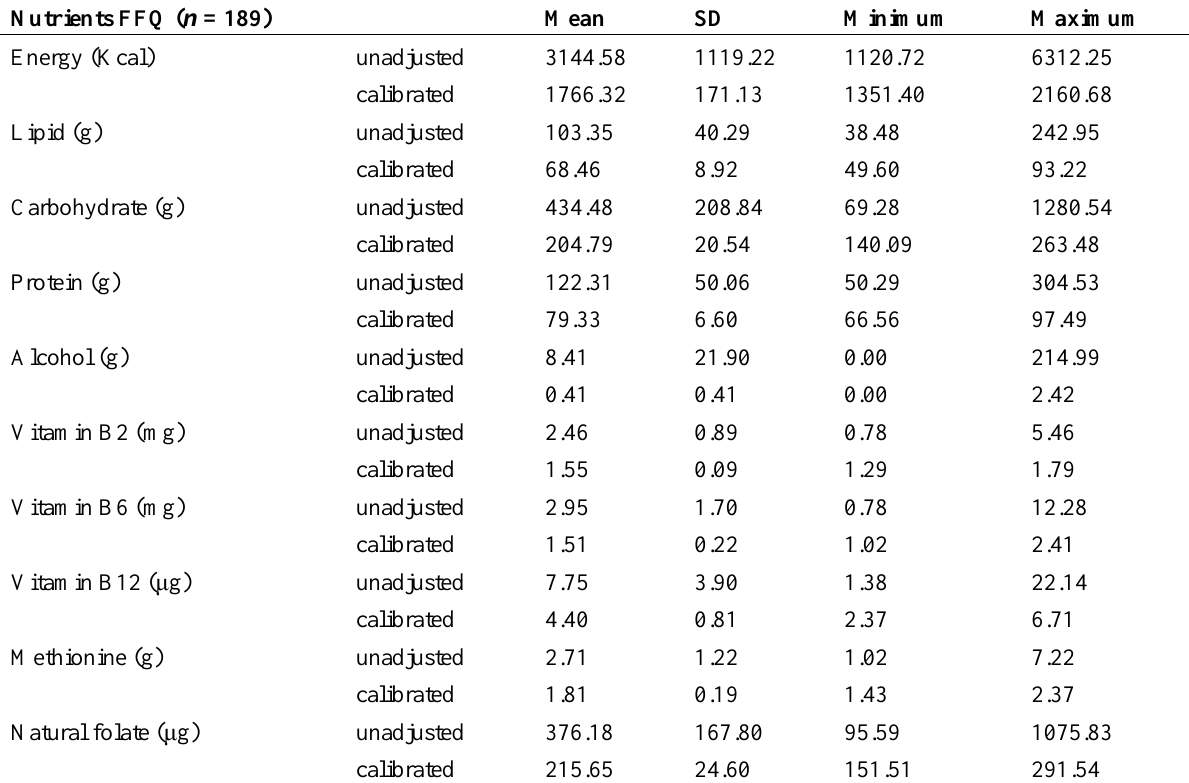
Table 1. Mean, standard deviation and minimum and maximum nutrient values from the unadjusted and calibrated FFQ in the pretreatment of patients for colorectal